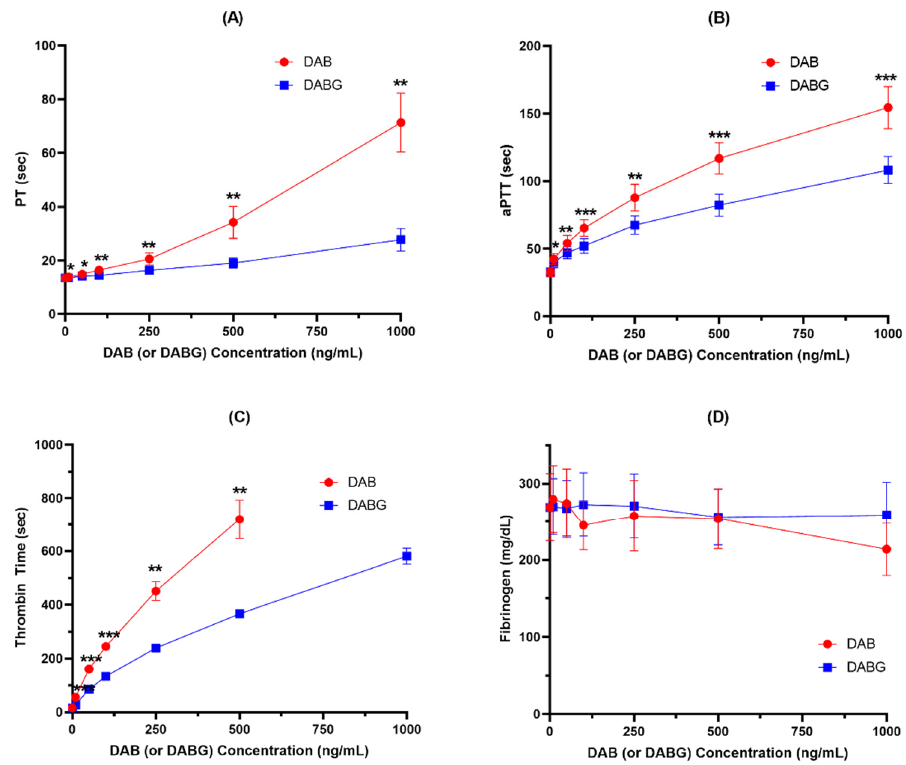
Figure 3. Anticoagulant effects of DAB and DABG assessed by PT ( A ), aPTT ( B ), TT ( C ), and fibrinogen ( D ) ( n = 5). *, p < 0.05; **, p < 0.01; ***, p < 0.001. Both DAB and DABG produced inhibitory effects on PT, aPTT, and TT in a concen- thrombin generation, DAB exhibited a stronger anticoagulant effect than DABG. How- ever, neither DAB nor DABG had an inhibitory effect on fibrinogen formation. 3.3. Combination Effect of DAB and DABG on Thrombin Generation DABG is the main active metabolite formed from DAB, and both are found simulta- neously in the plasma after administration in humans. Thus, we assessed the combined effect of DAB and DABG, using a thrombin generation assay to determine whether DAB and DABG exhibited additive effects. Considering that DABG showed a relatively weaker anticoagulant effect than DAB, the combination of DAB and DABG could present stronger anticoagulant effects than DAB or DABG alone. When the mixture of DAB and DABG was co-incubated, the inhibitory effect of thrombin generation was weaker than that of DAB alone, considering the same amount, but was stronger than DABG alone, indicating that DAB and DABG showed an additive effect on their anticoagulant effect and that the anticoagulant effect of DABG is not equal to that of DAB (Figure 4).